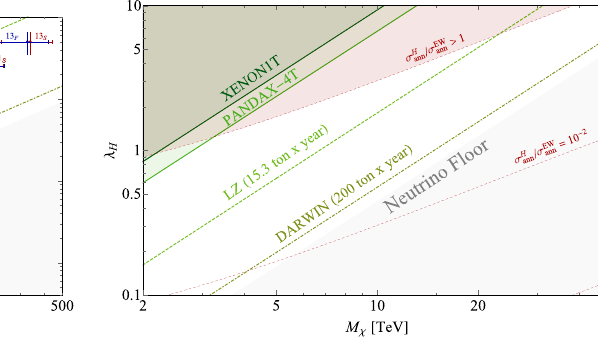
TheverticalerrorbandscorrespondtoLQCDuncertaintiesontheelastic cross-section in Eq. (41) while the horizontal error band comes from the theory determination of the WIMP freeze out mass. Right: current and future reach on the Higgs portal quartic λ H defined in Eq. (1) for scalar DM. In the shaded dark red region the quartic modifies the freeze-out cross-sectionby O ( 1 ) ormore.Thedashedredcontoursindicatesmaller ratios of the Higgs-portal and the EW annihilation